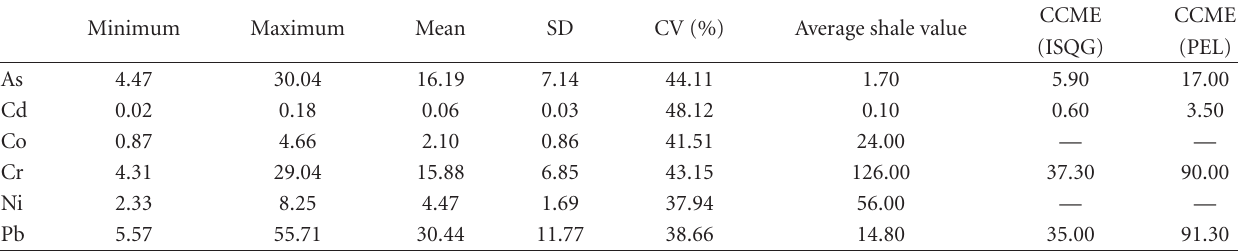
Table 6: Descriptive statistics of heavy metal concentrations (mg/kg) in sediment samples at Langat River ( n =